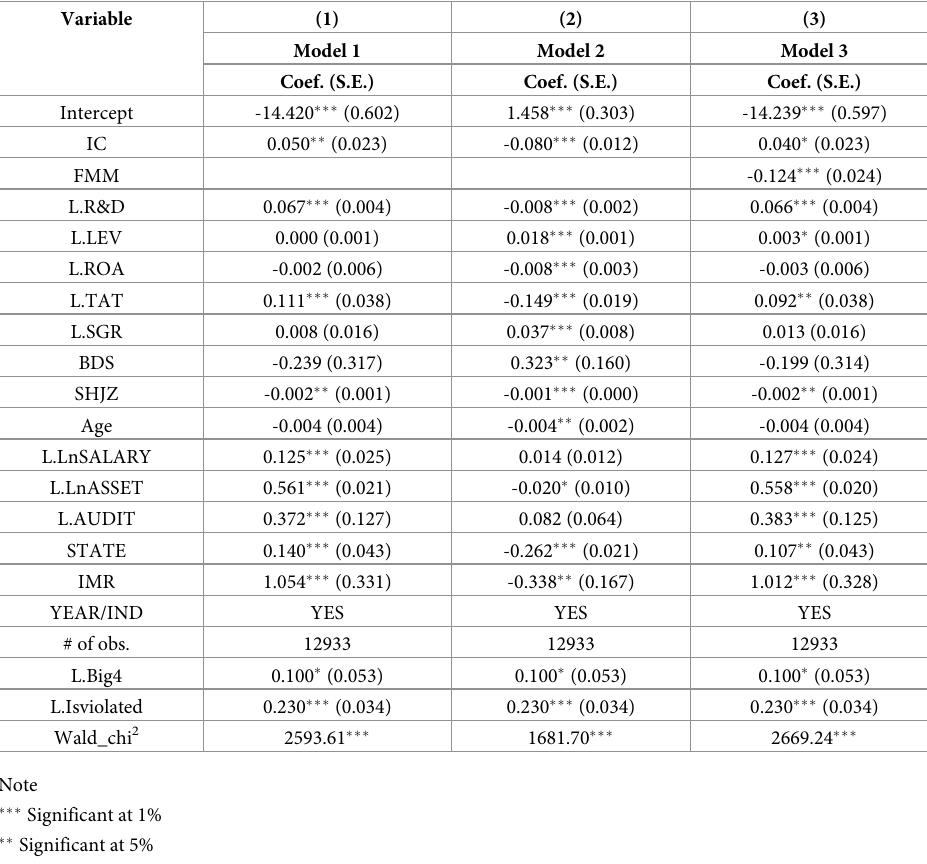
Table 5. Test results for heckman two-step